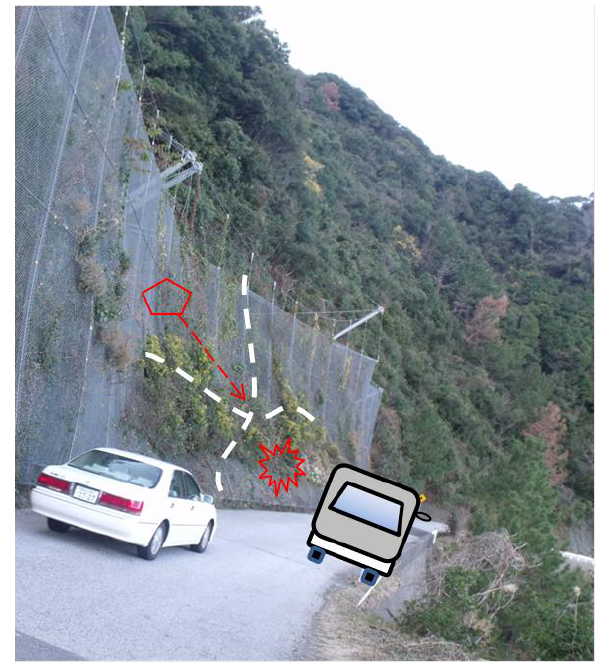
Fig. 4. A simple schematic illustration of the reason for putting Figure 4. A simple schematic illustration of the reason for putting the (out-of-plane) 2 the (out-of-plane) displacement response into priority in evaluat- displacement response into priority in evaluating the performance of an LPR structure. The 3 ing the performance of an LPR structure. Actually, the structure is constructed very close to the road-carriageway and the risk onto structure is constructed very close to the road carriageway and the risk onto the road traffic 4 the road traffic due to a larger displacement of wire-net needs to due to a larger displacement of wire-net needs to be checked. Illustrations are drawn over a 5 be checked. Illustrations are drawn over a recent photo of a well- functioning structure from a site along Kurei-Suzaki Line road in recent photo of a well-functioning structure from a site along Kurei-Suzaki Line road in 6 Kochi Prefecture of Japan, installed later 2009. Kochi Prefecture of Japan, installed later 2009. 7